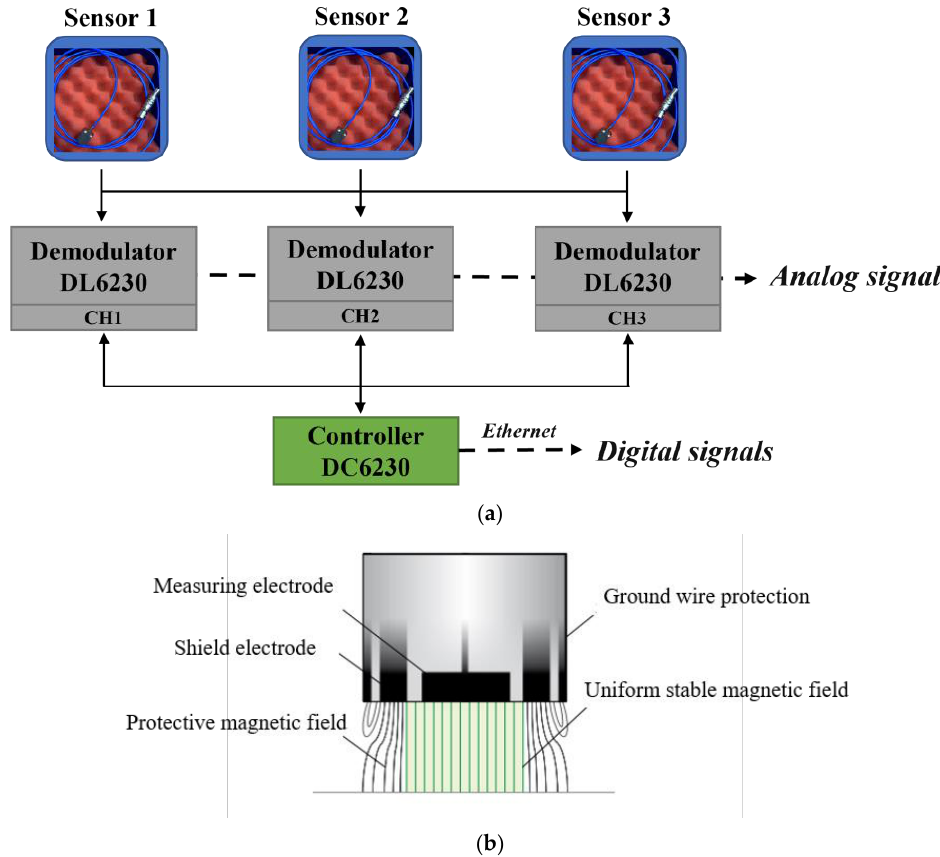
Figure 5. ( a ) Control system of capacitive displacement sensor. ( b ) Distance measuring diagram of capacitive sensor.